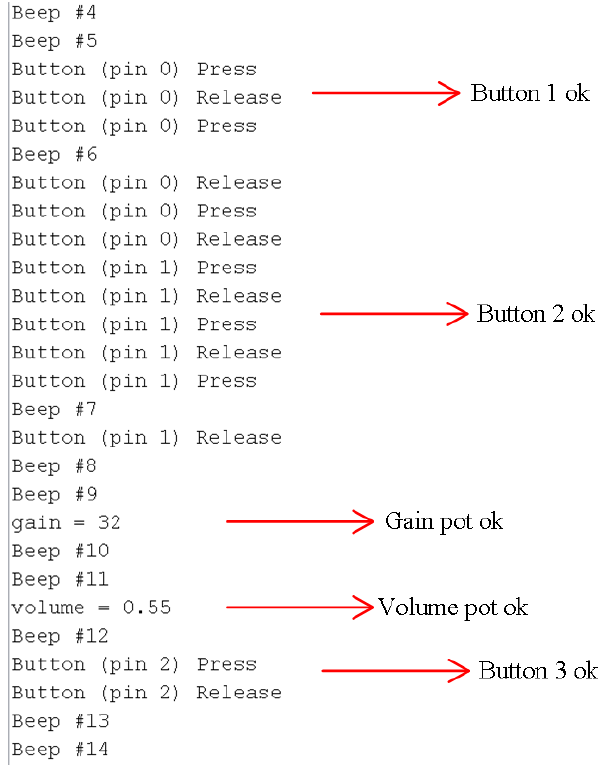
Figure 16. Mechanical peripherals test.